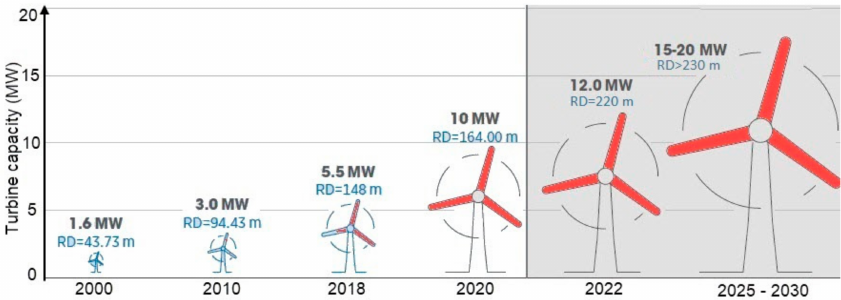
Figure 4. Power and rotor diameters of existing and planned offshore wind farms [2].